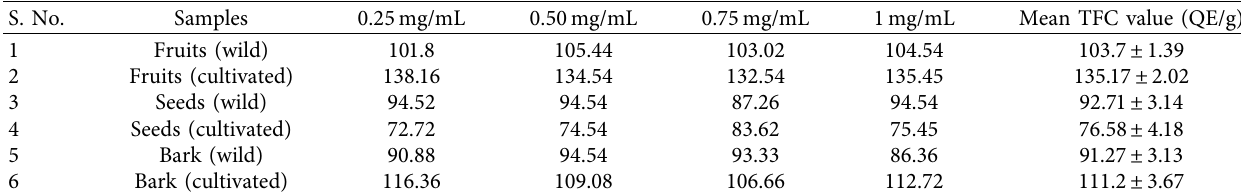
Table 2: Total flavonoid contents (TFC) in different extracts of Z . armatum